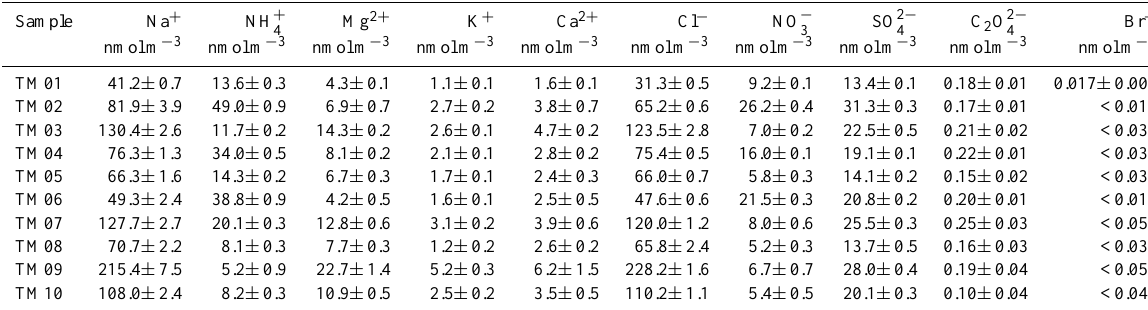
Table 3. Concentrations of aerosol soluble major ions during the M91 cruise.